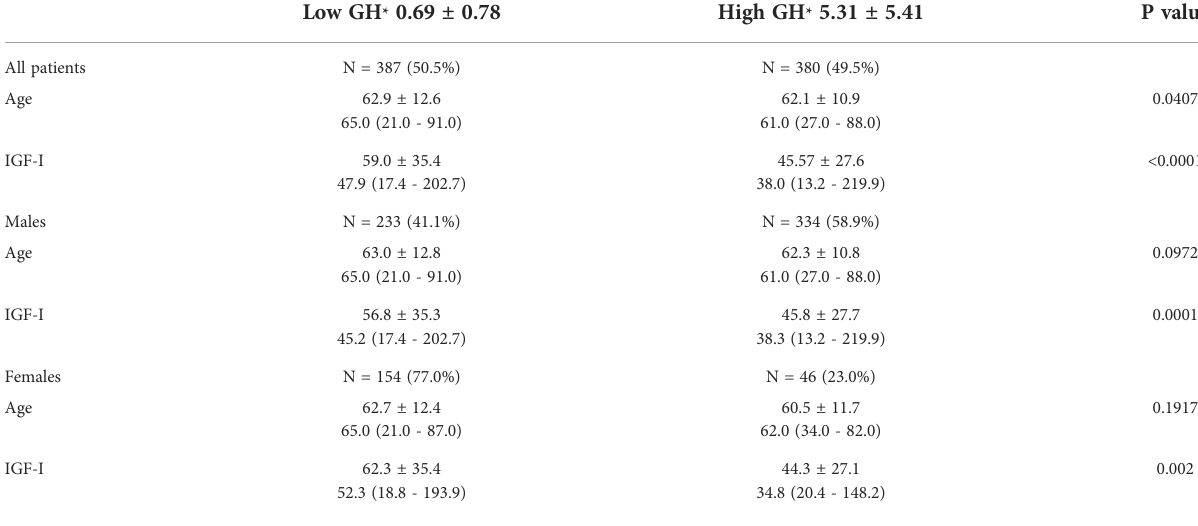
TABLE 2 Age and IGF-I levels (ng/ml) in HCC patients with low vs. high GH